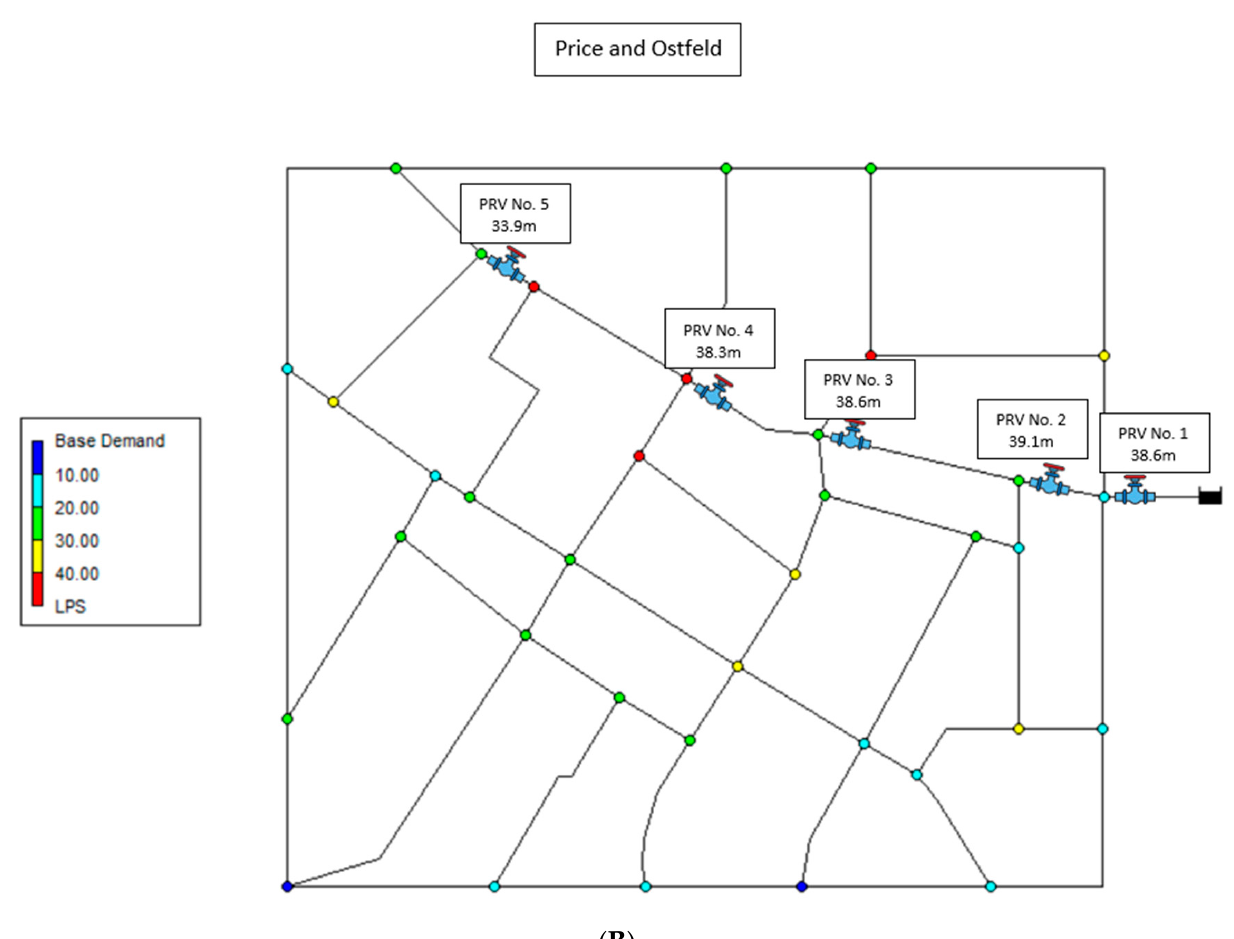
Figure 7. ( A ) PRV locations obtained by applying Shmaya and Ostfeld’s method on the Fossolo network. ( B ) PRV locations obtained by applying Price and Ostfeld’s method on the Fossolo network.